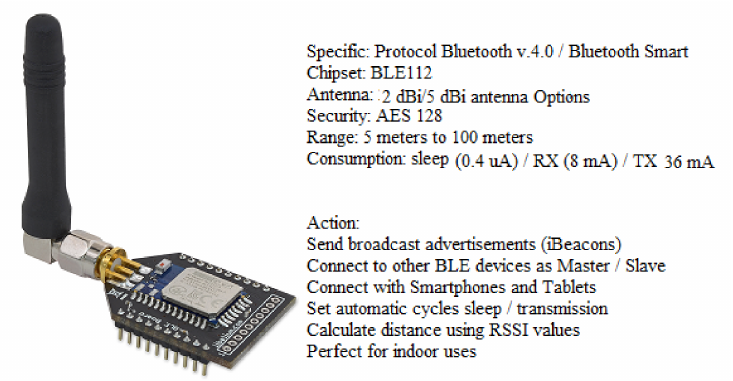
Figure 4. BLE/MuSense used in SNIS